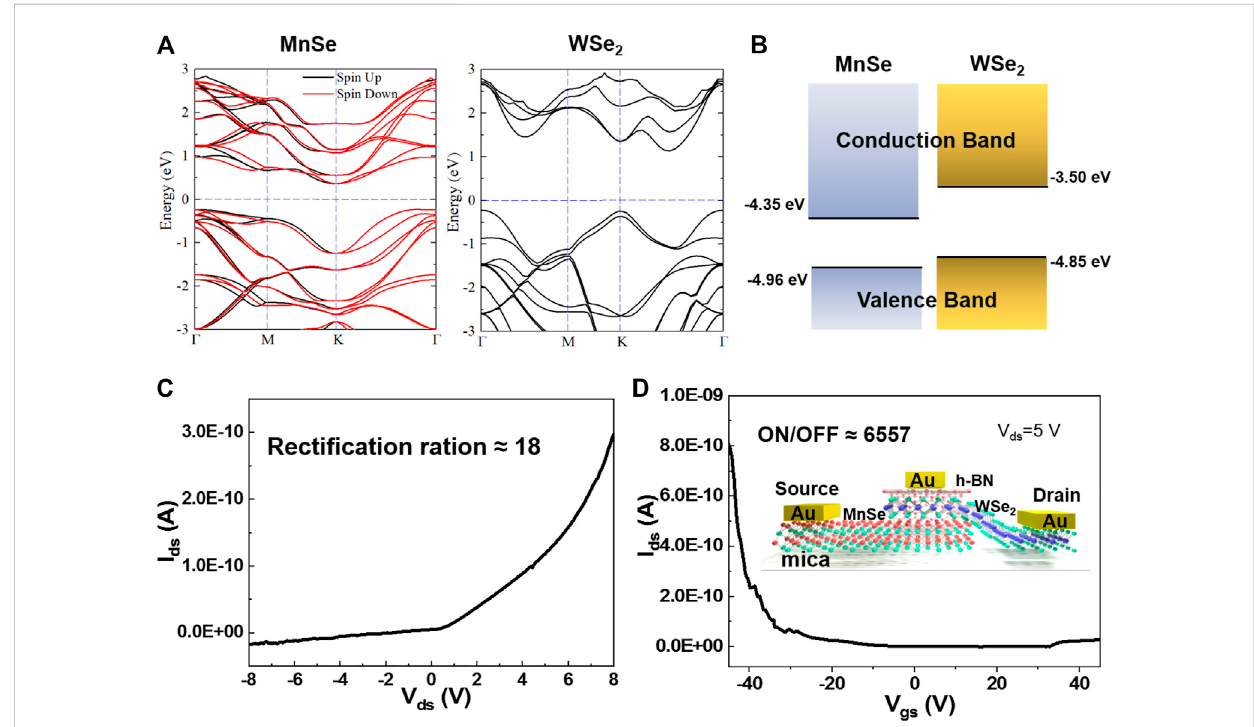
FIGURE 3 (A) Calculated band structures of 2D MnSe and WSe 2 , respectively. (B) Band alignments of MnSe and WSe 2 before contact. (C) The I ds – V ds characteristic curve at V g = 0 V and (D) the transfer curve at V ds = 5 V of the MnSe/WSe 2 heterojunction FET with h-BN top